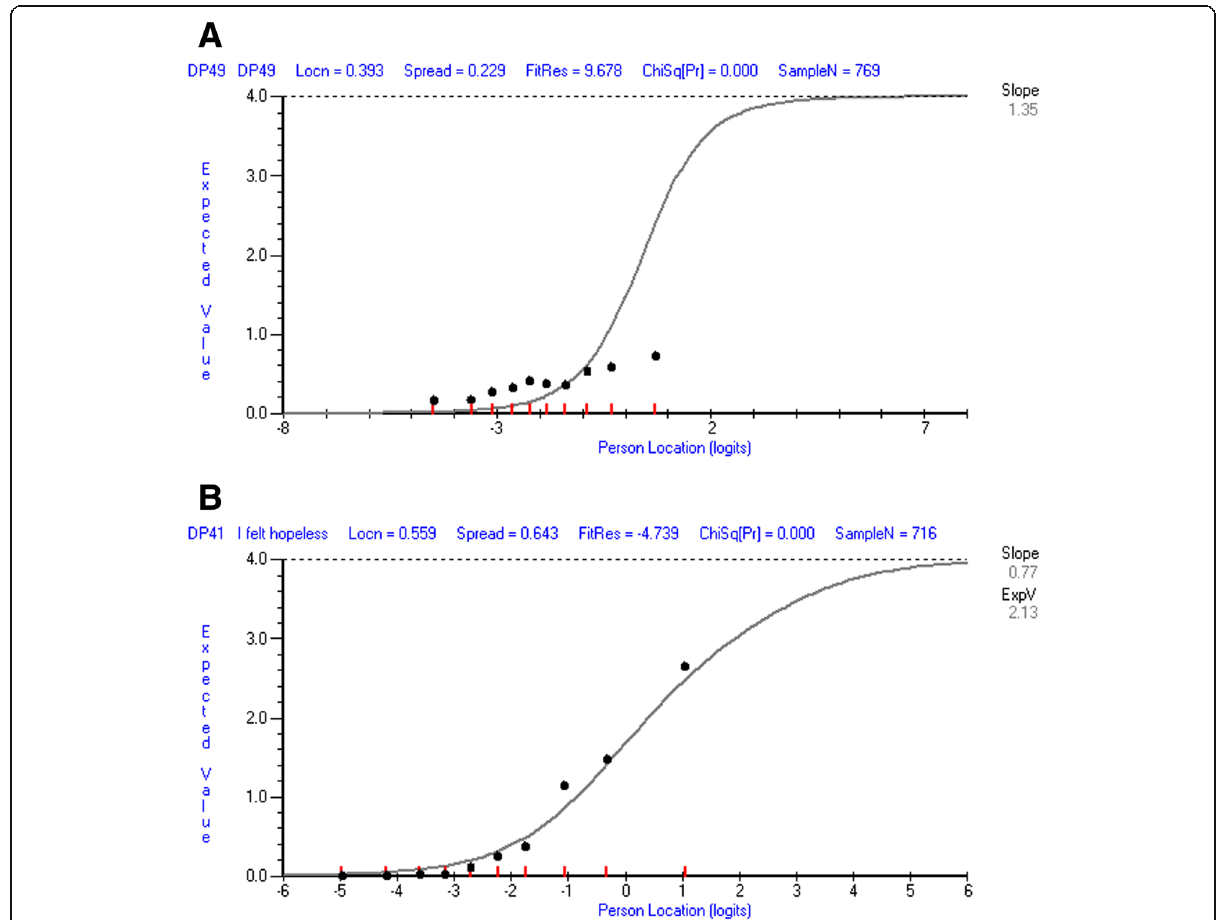
Fig. 3 Exemplar Item Characteristic Curves (ICC) for items displaying the worst Statistical Misfit. Item characteristic curves for the items displaying the worst statistical misfit. The y-axis represents the scores expected by the Rasch model and the x-axis the depression measurement continuum of the sample. The ICC plots the observed scores in each of the 10 class intervals of depression (the black dots) and the scores expected by the Rasch model at each level of the measurement continuum (the curve). ( a ) item 49 “ I lost weight without trying ” of the 51-item bank indicating evident underestimation of depression as observed scores at higher person location logits are located below the expected curve and scores at lower person location logits higher than the expected curve. ( b ) item 41 “ I felt hopeless ” of the 28-item bank indicating marginal overestimation of depression as observed scores at higher person location logits are located above the expected curve and observed